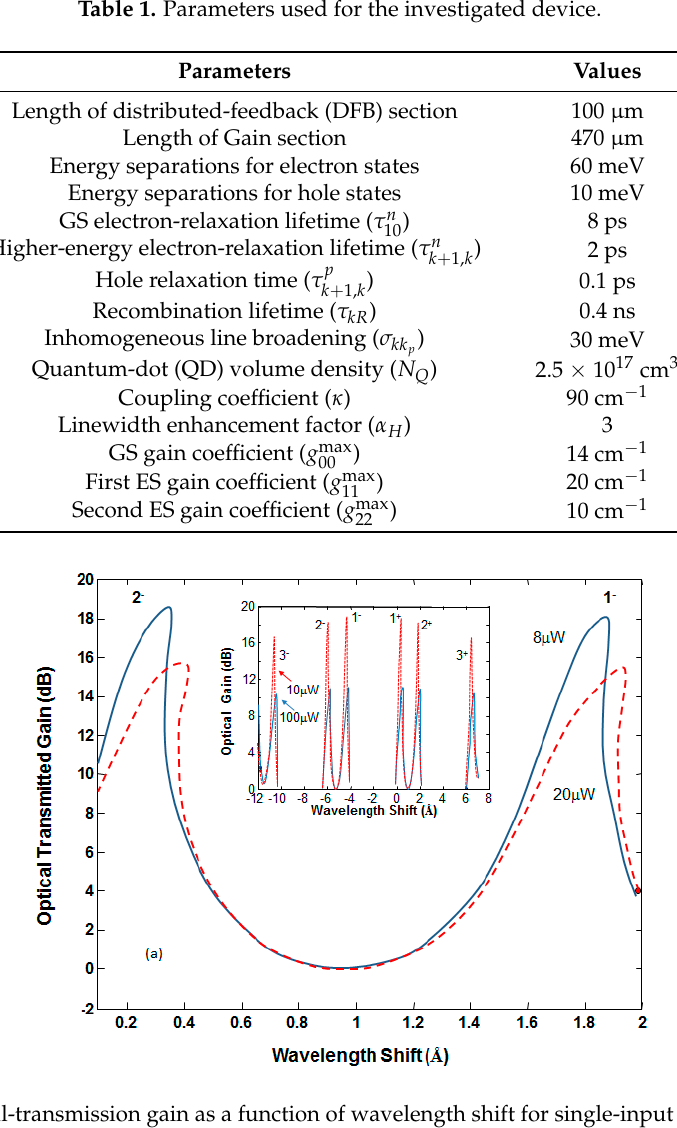
Table 1. Parameters used for the investigated device.